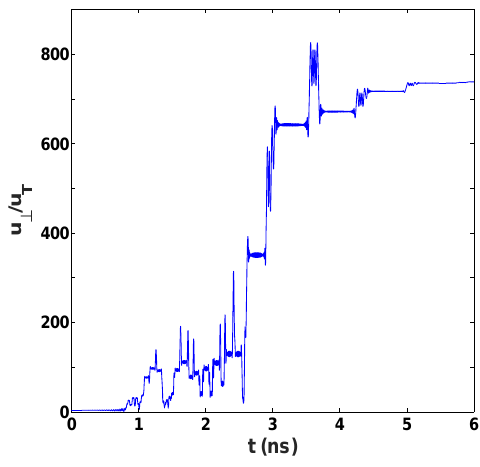
Figure 8. Same as Fig. 6 except that the beam power is 10 MW